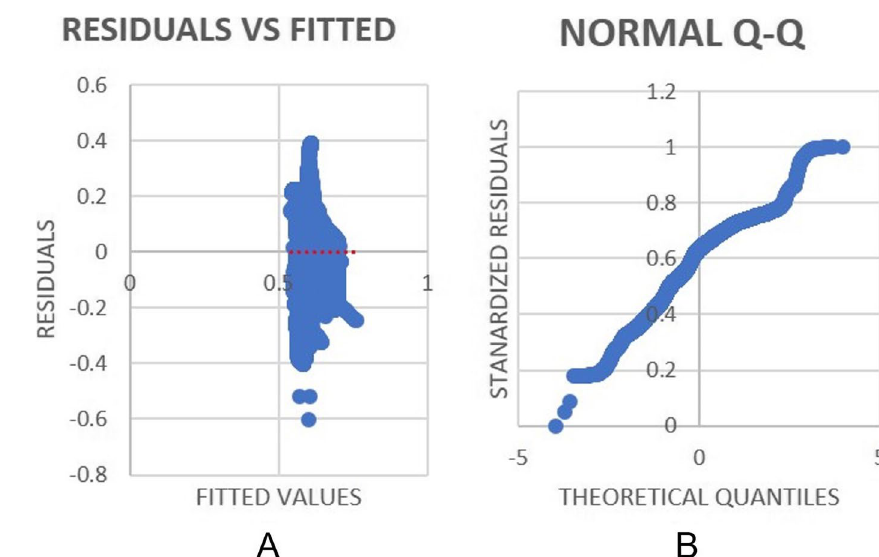
Fig. 10 HR Regression: Residuals VS Fitted values curve ( A ) and Q-Q Plot ( B